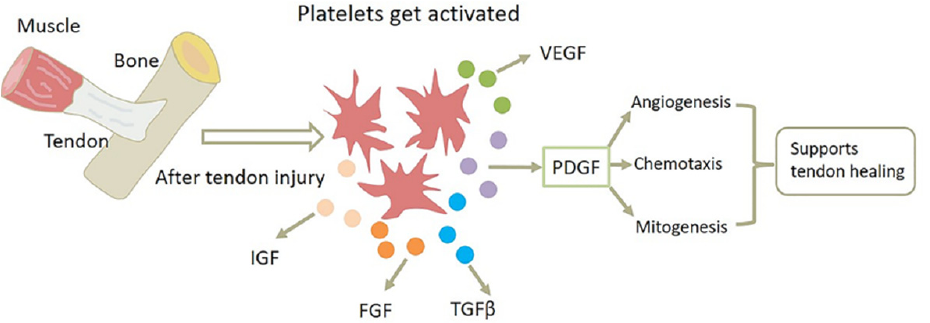
Figure 3. PDGF promotes angiogenesis and uses its chemotactic and mitogenic properties to support tendon healing.